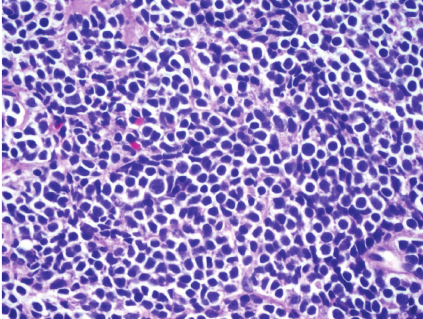
Figure 3: The lacrimal masses showing a monotonous proliferation of small lymphocytes with hyperchromatic, angulated nuclei and scant cytoplasm. There are hyalinized vessels noted in the back- ground (H&E; 400x